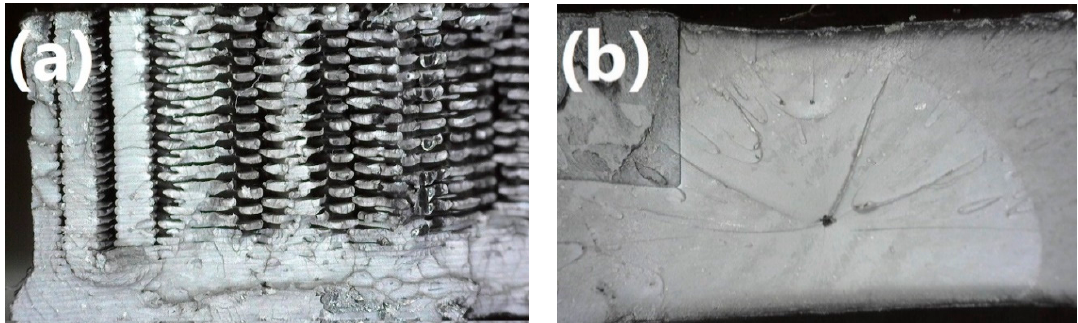
Figure 3. Fracture areas obtained after tensile tests for ( a ) 3D printed sample with infill angle of 55’° and ( b ) injection molded sample.